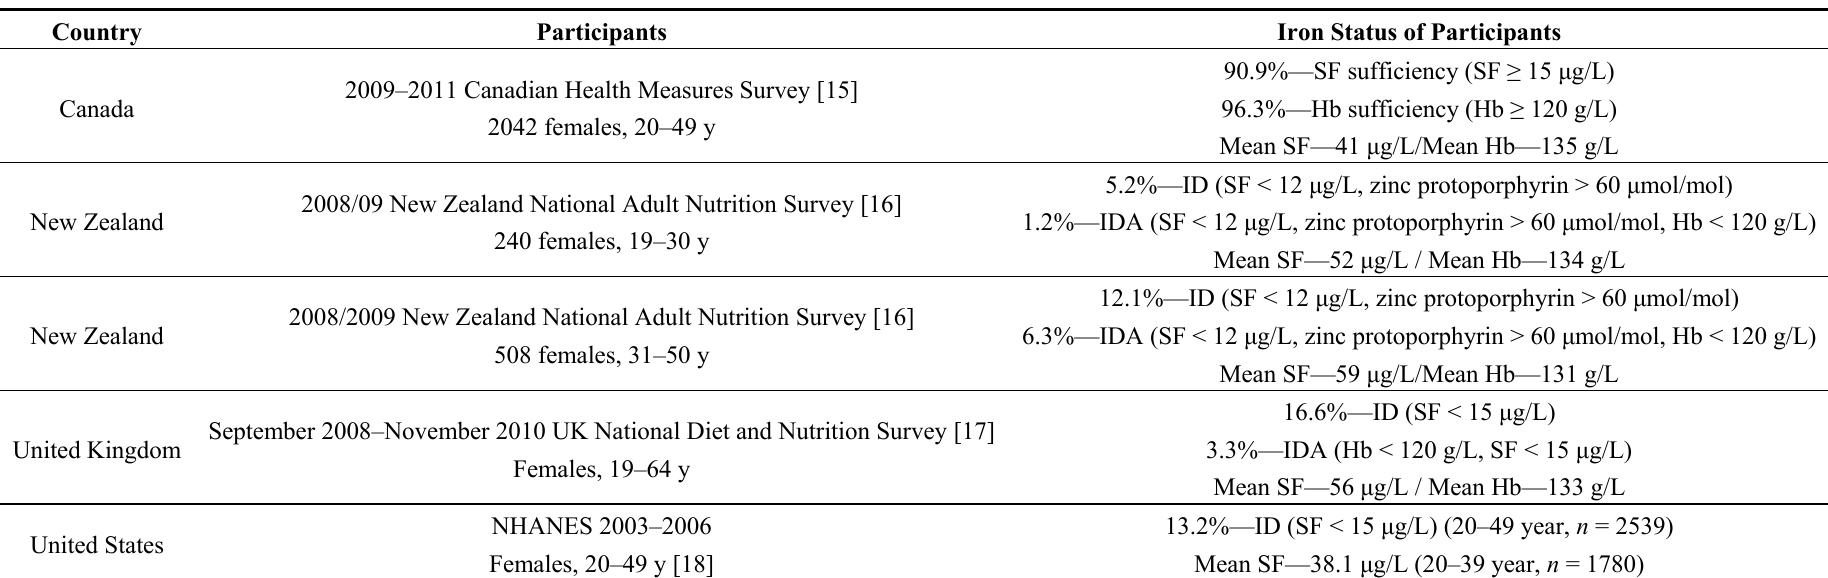
Table 1. National prevalence data for iron deficiency and iron deficiency anemia for young women from industrialized countries from national nutrition and health surveys a